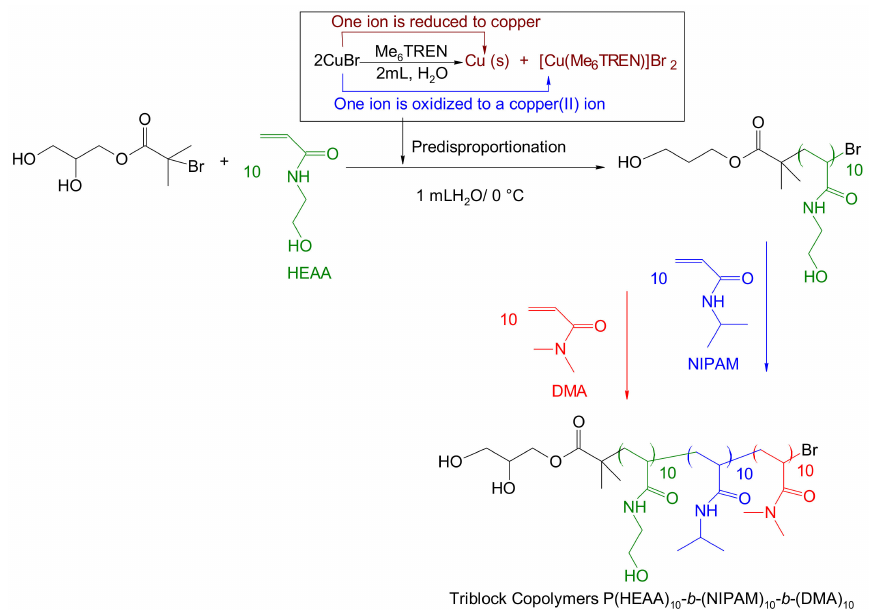
Scheme 1. Synthesis of triblock copolymers composed of HEAA, NIPAM and DMA by itera-